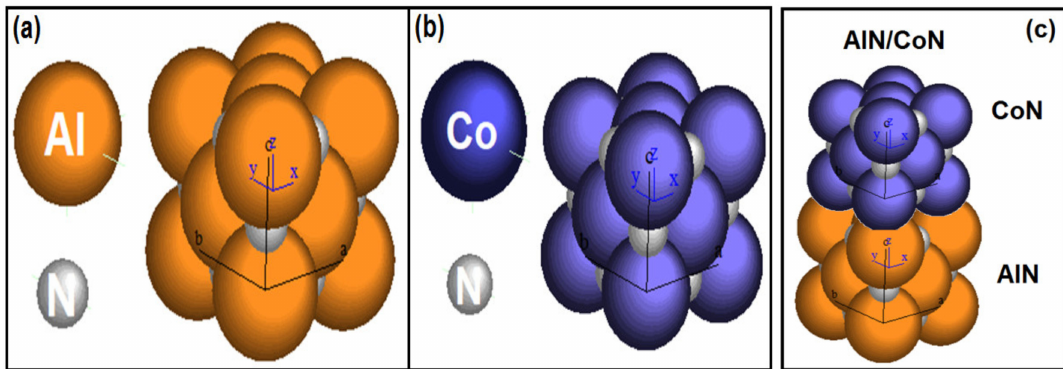
Figure 7. Unit cell crystallographic simulation obtained using CaRIne Crystallography 3.1 software: ( a ) AlN materials, ( b ) CoN materials and ( c ) [AlN/CoN]n mulyilayers.